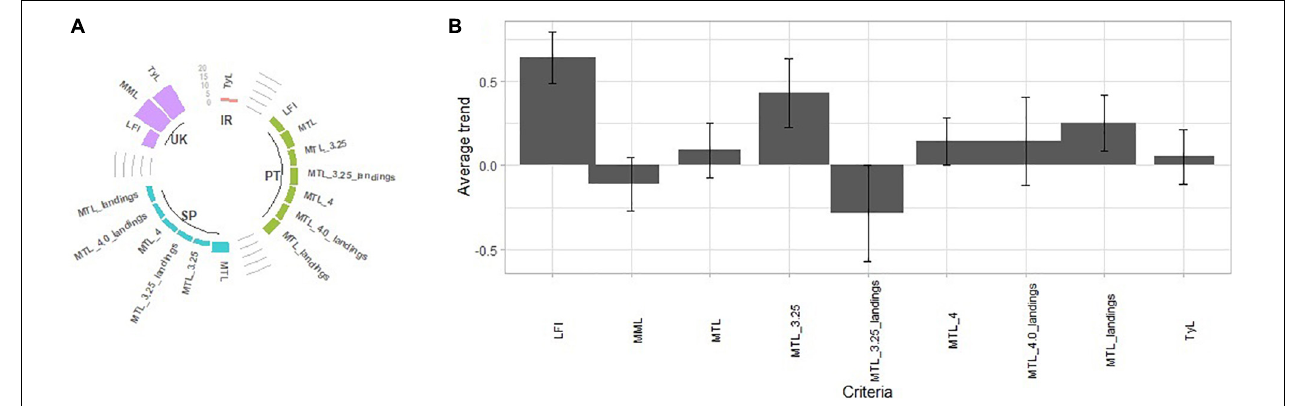
FIGURE 4 | Number of fish criteria reported per Member State (A) and average assessment trend for fish food web indicators (B)